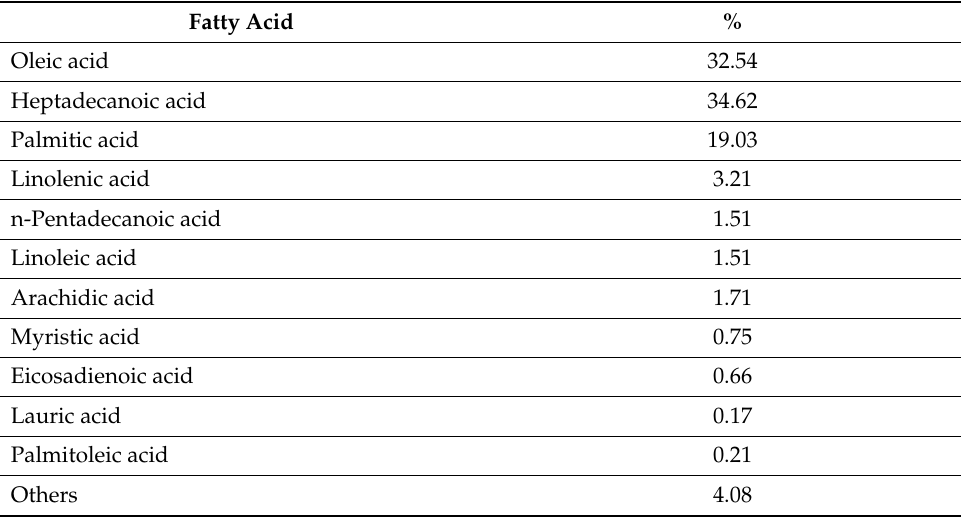
Table 1. Waste sunflower cooking oil chemical